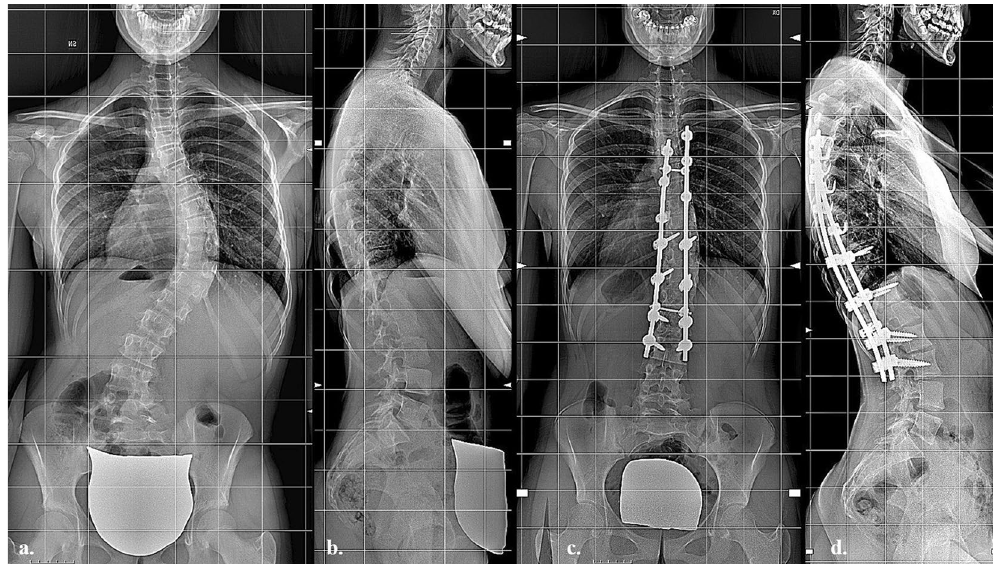
Figure 2. ( a ) Anteroposterior pre-operative long-cassette X-Ray of a 1C-Adolescent Idiopathic Scoliosis in a 15 years patients with Risser 3; ( b ) lateral pre-operative long-cassette X-ray showing hypokyphosis < 20°, ( c ) post-operative anteroposterior long-cassette X-ray showing satisfactory correction with hybrid construct, ( d ) lateral post-operative long-cassette X-ray showing restoration of normal